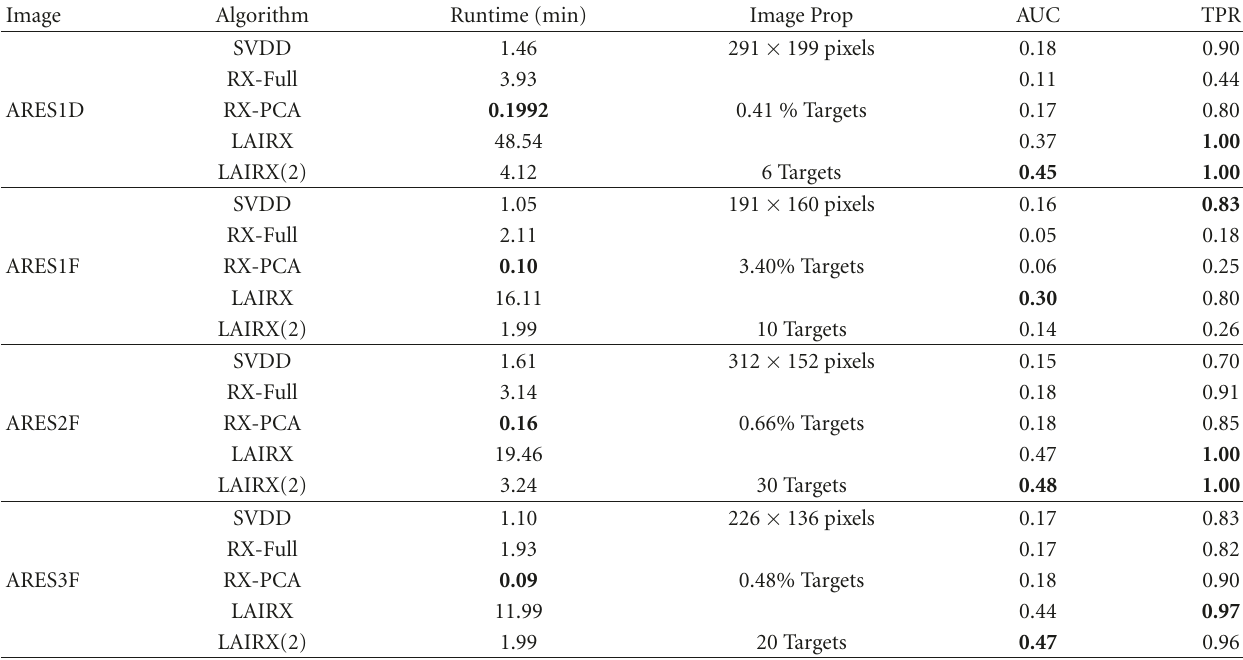
Table 1: Tabular results by